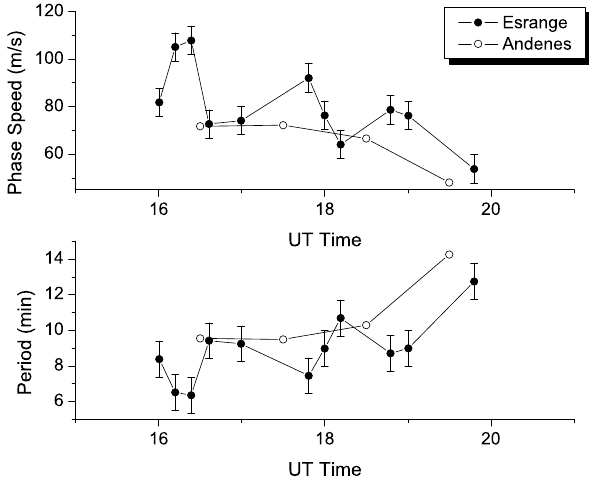
Fig. 6. Geographic projection of wave 2 observed on 27/28 January at 16:37 UT and 17:47 UT. As the wave progressed over both meteor radars the data are ideal for comparison of the intrinsic wave parameters derived from both wind data sets.